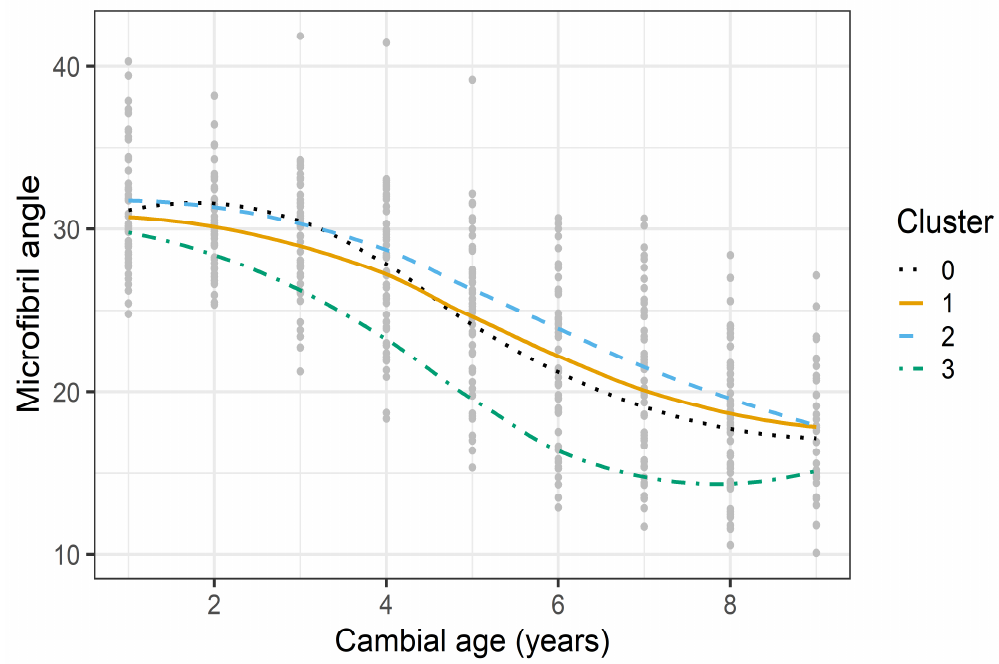
Figure 6. Microfibril angle (MFA) radial variation for trees representing the average wood property values of each cluster.